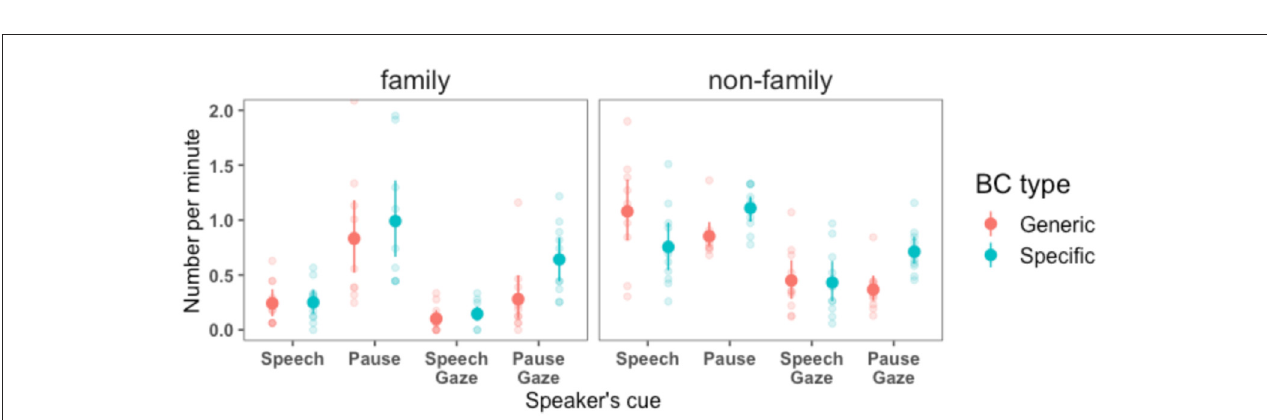
FIGURE5 The rate of listener’s BC production in family and non-family adult dyads across the speaker’s speech and pauses (mutually exclusive). We also show the subset of cases where these cues overlap with the speaker’s gaze at the listener. Each data point represents a participant and ranges represent 95% confidence intervals.